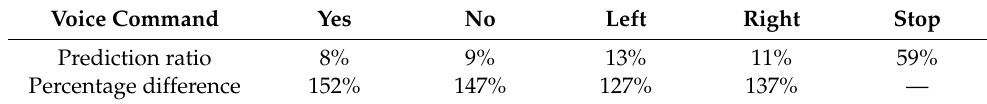
Table 7. Percentage difference between “stop” command and other commands.